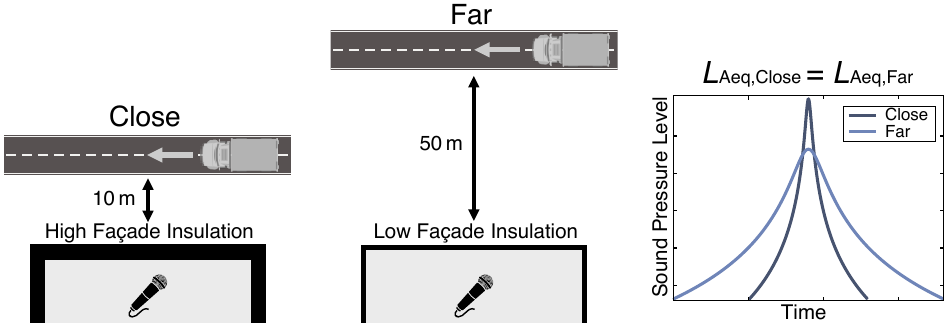
Figure 1. Visualization of the relation between source distance and indoor noise time structure for a typical road-traffic scenario with adapted façade insulation. Even though the equivalent indoor sound pressure levels for both cases are exactly the same, the time structure of the two signals is different since the maximum sound pressure level L AF,max decreases by ≈ 6 dB per distance doubling while the time-averaged sound pressure level L Aeq only decreases by ≈ 3